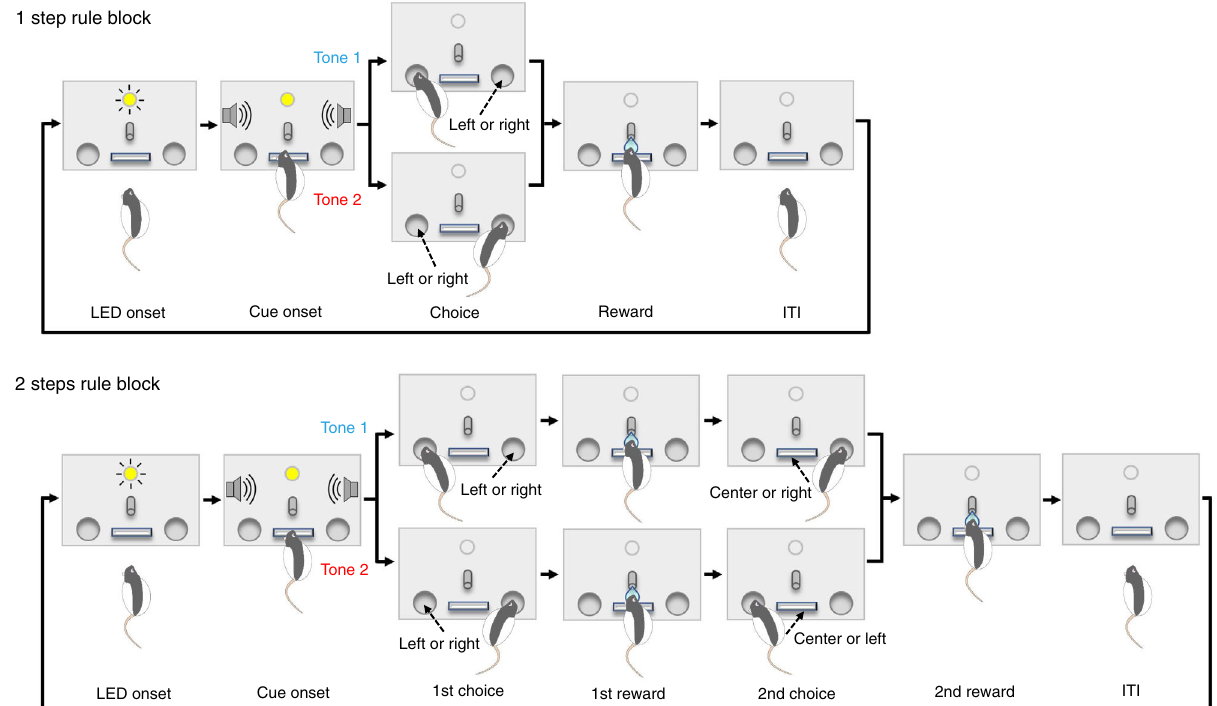
Fig. 1 | Conditional action sequencing task. Rats were trained and tested in a chamberinwhichalever,awaterspout,andanLEDwereinstalledonthefrontwall with two infrared (IR) ports on the left and right sides. Sound speakers were equipped on side walls. Task rules were switched between 1 step rule and 2 steps conditions every 55 trials. LED onset signals the end of the inter-trial interval (ITI) and rats can start a new trial by pushing the center lever. In 1 step condition